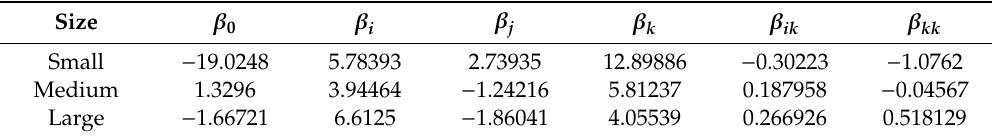
Table 5. Regression coefficients ( β ) for peel loss (PL) of small, medium and large cassava tubers after enzymatic treatment and mechanically peeling.